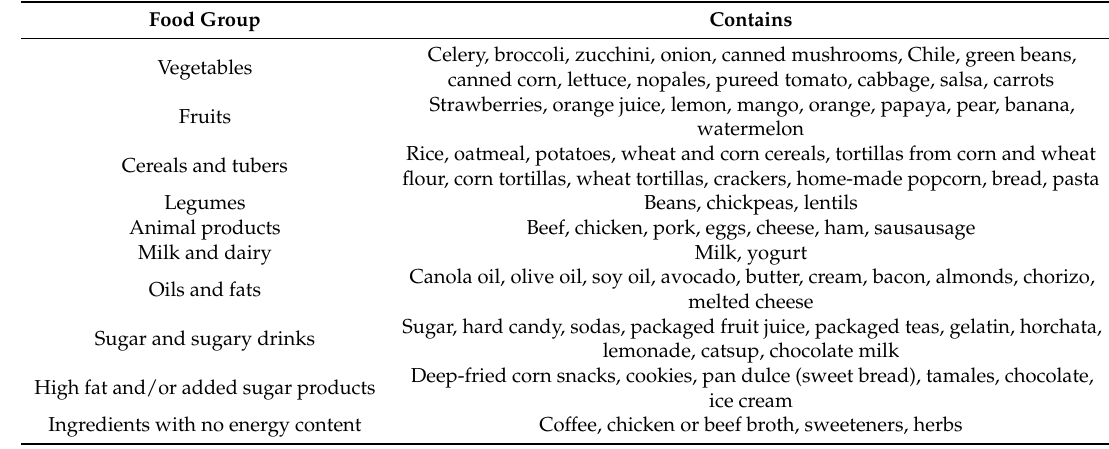
Table A1. Food groups by